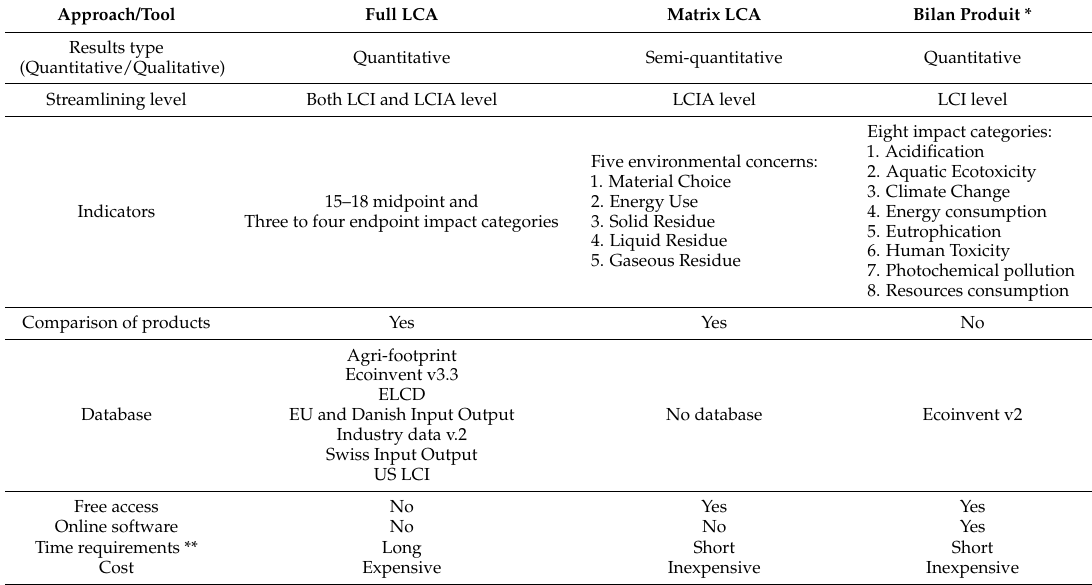
Table 3. Main characteristics of the full and streamlined